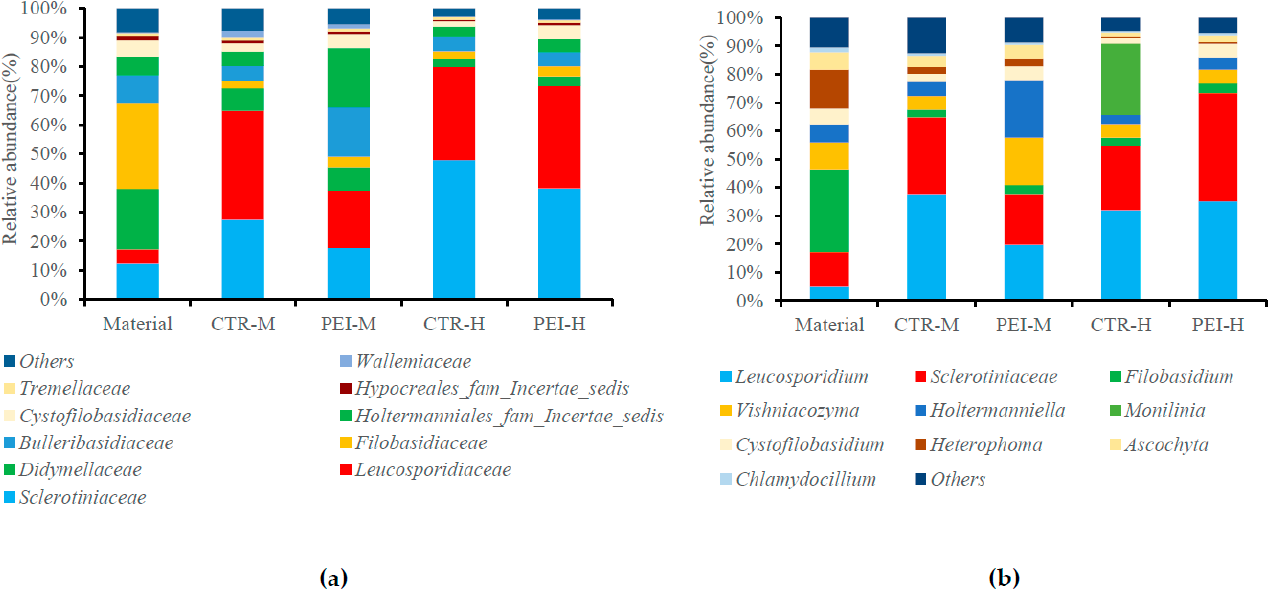
Table 6. Relative abundance (%) of material, bacterial genus and fungal genus in alfalfa silages en- siled for 60 d, as analyzed by the sequencing of the V4–V5 region of the 16S rRNA, for bacteria, and ITS1, for fungi, using the Illumina MiSeq platform.